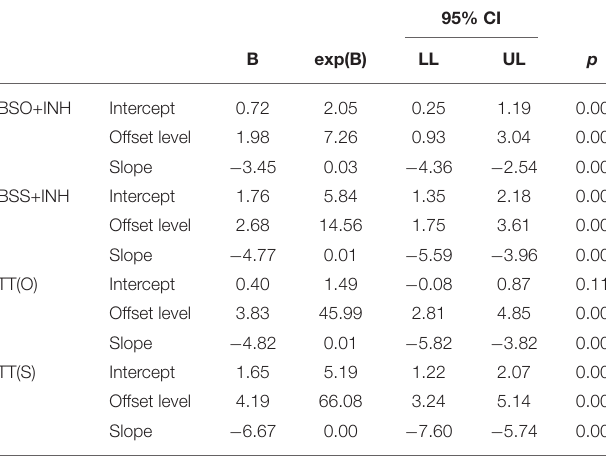
TABLE 3 | Coefficients of the inhalatory model for all intervals involving an inhalation.